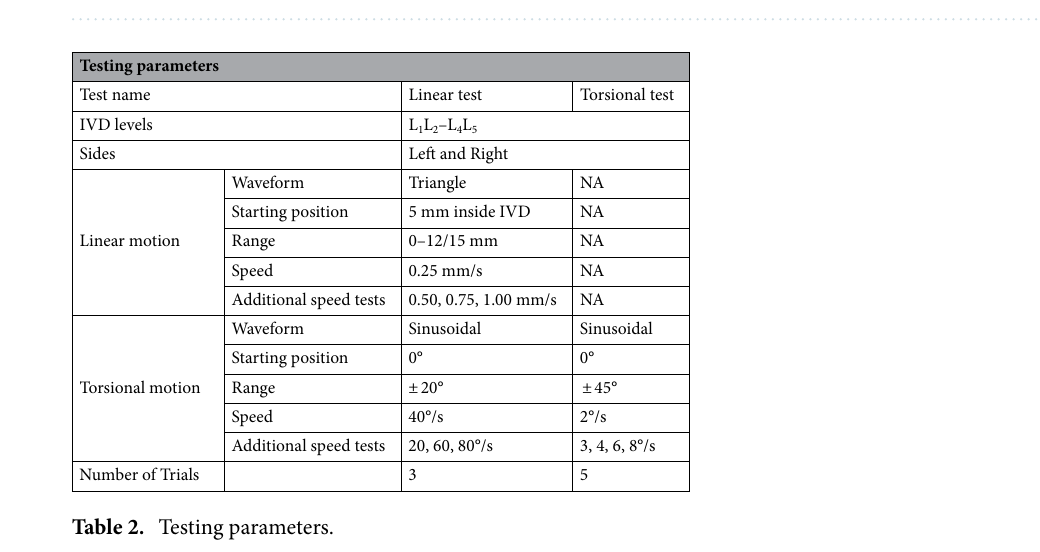
Figure 2. Examples of linear ( a ) and torsional ( b ) tests with extracted peak and resistance values for the first trial of the right side of C2 L 3 L 4 . The torsional test was performed at a 5 mm depth. Schematics of the tool orientation within the intervertebral disc (IVD) are shown.